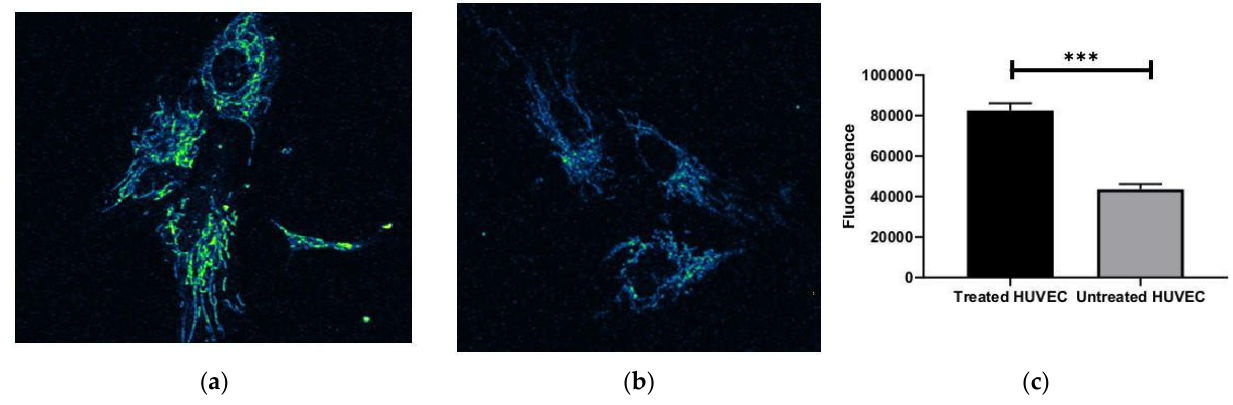
Figure 4. Mitochondrial membrane potential of HUVECs treated with DFO-sEVs compared to untreated cells. Representative images of ( a ) treated and ( b ) untreated HUVECs. ( c ) Fluorescence intensity quantification with ImageJ software vs8. *** p -value < 0.001.